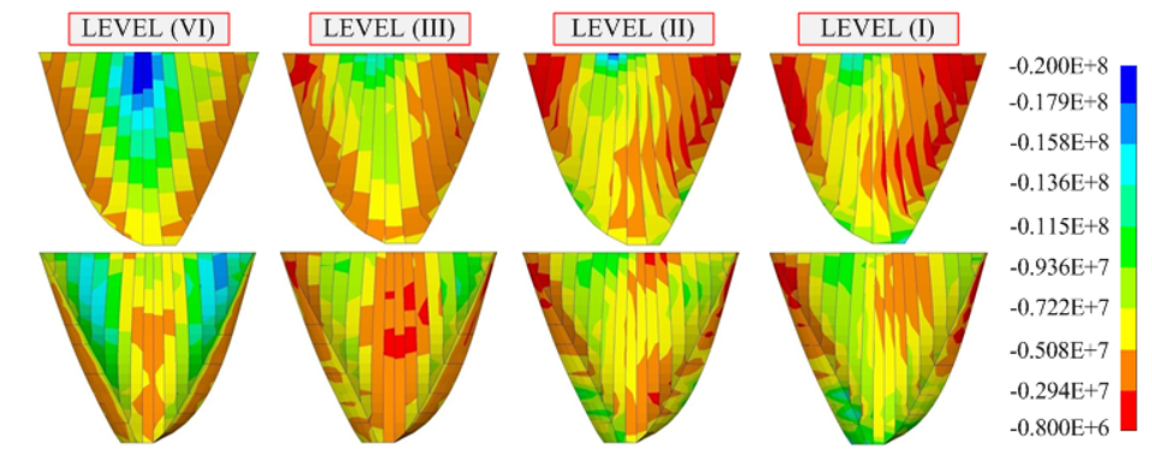
Figure 19. Non-concurrent envelope of the minimum third principal stresses; (Pa)